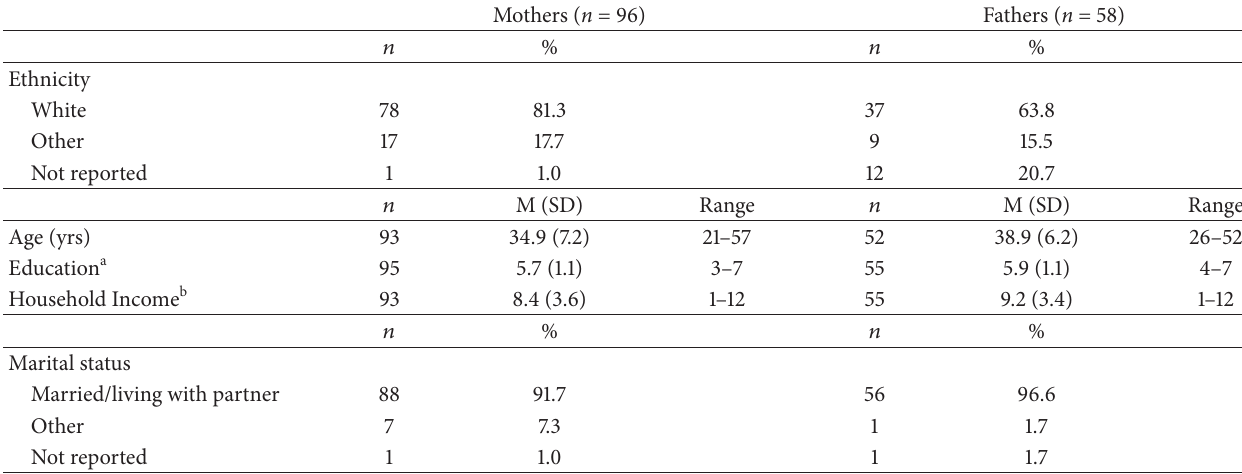
Table 2: Parent demographic characteristics.